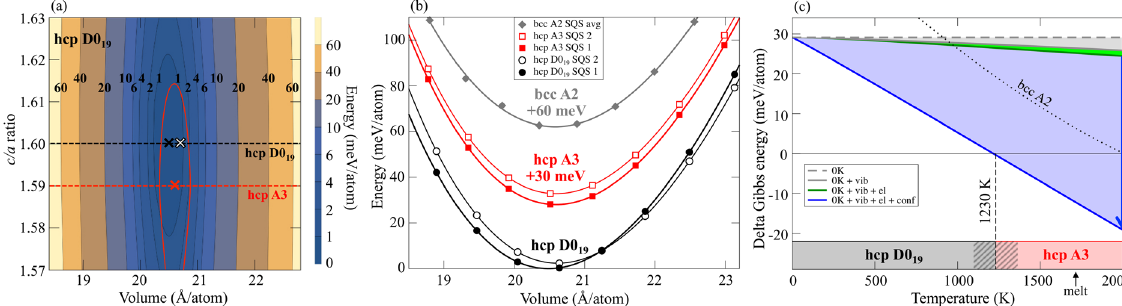
Figure 4. Ab initio energetics of the hcp based phases D0 19 and A3, and of the bcc based A2 phase for the Al 15 Hf 25 Sc 10 Ti 25 Zr 25 at.% HEA. ( a ) Energy contour plot at T = 0 K for the D0 19 phase as a function of volume and c/a ratio. The bold black numbers give the value of the contours in meV/atom. The black dashed line indicates the equilibrium c/a ratio (of SQS 1) and the black and white crosses mark the equilibrium volumes of the two employed supercells (SQS 1 and 2). The red solid line shows the 1 meV/atom contour of the hcp A3 energy surface. The red dashed line indicates the equilibrium c/a ratio for hcp A3 and the red cross the corresponding equilibrium volume. ( b ) T = 0 K energy-volume curves for D0 19 and A3 (with two SQS’ for each phase) at the equilibrium c/a ratios as indicated by the dashed lines in ( a ). The energy-volume curve of bcc A2 which has been obtained by an average over the two studied SQS supercells (see the Methods section on the ab initio energetics) is also shown. ( c ) Difference in the Gibbs energies of D0 19 and A3 as a function of temperature (D0 19 corresponding to the zero line). The Gibbs energy difference is decomposed into the T = 0 K energy (0 K), the vibrational (vib), electronic (el), and configurational (conf) contribution. The final curve corresponds to the blue solid line, resulting in a transition temperature of 1230 K as indicated by the vertical dashed line. The dotted line shows the difference between the Gibbs energy of D0 19 and bcc A2 containing all contributions. The onset of melting as obtained from our experimental results is indicated by the black arrow.